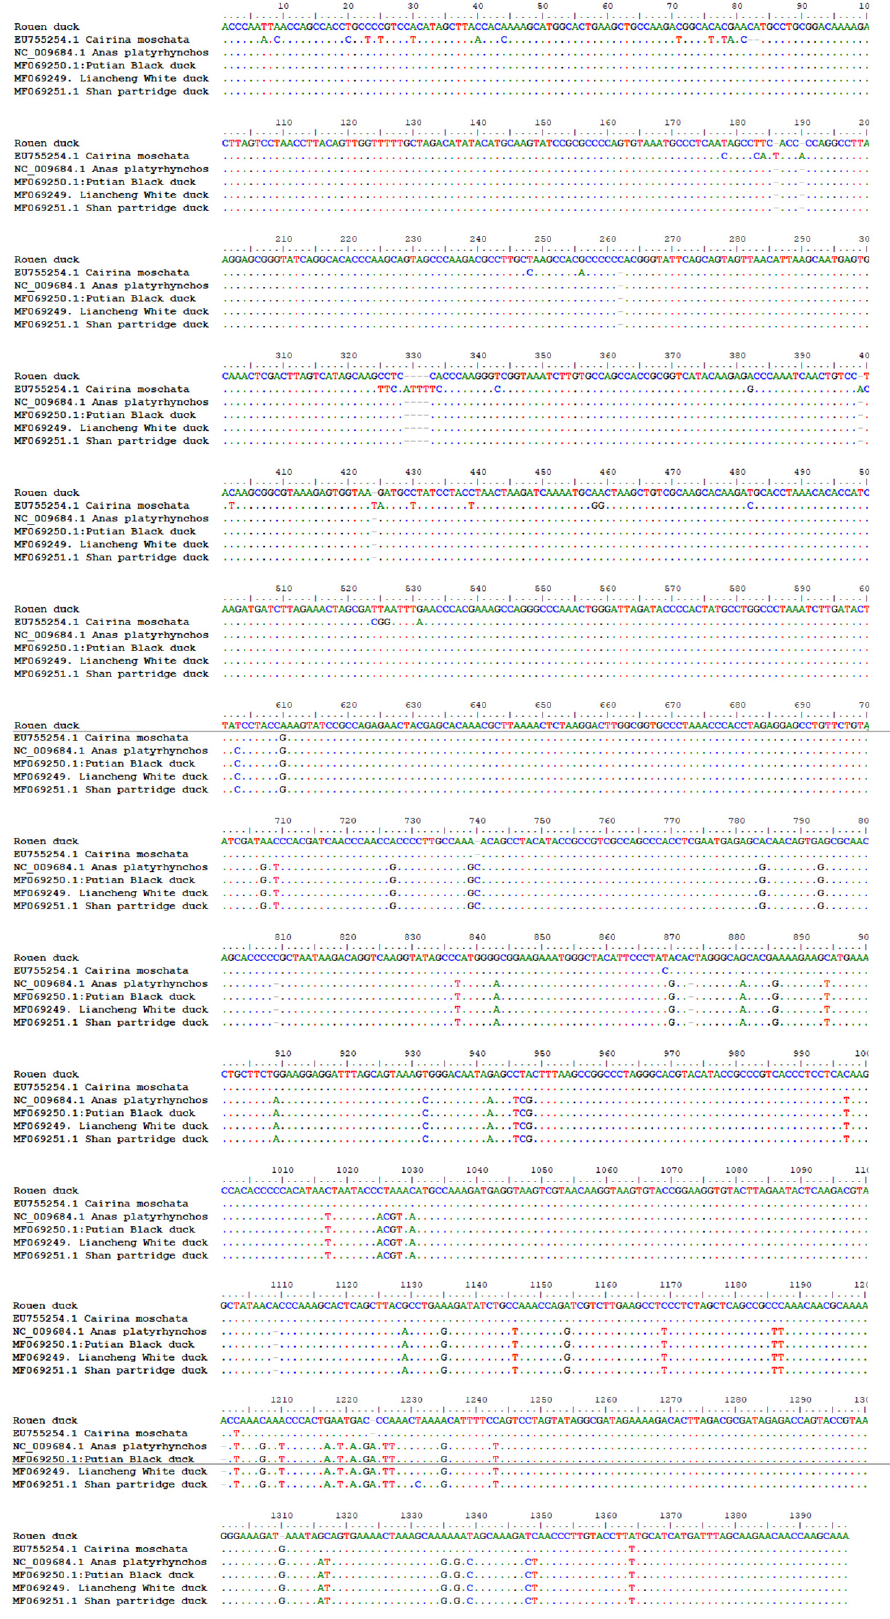
Figure 2. Multi-alignment sequences of duck DNA. The result of alignment sequences for the chosen duck breeds: Anas platyrhynchos , Cairina moschata, Putian black, Liancheng white, and Shan par- tridge.